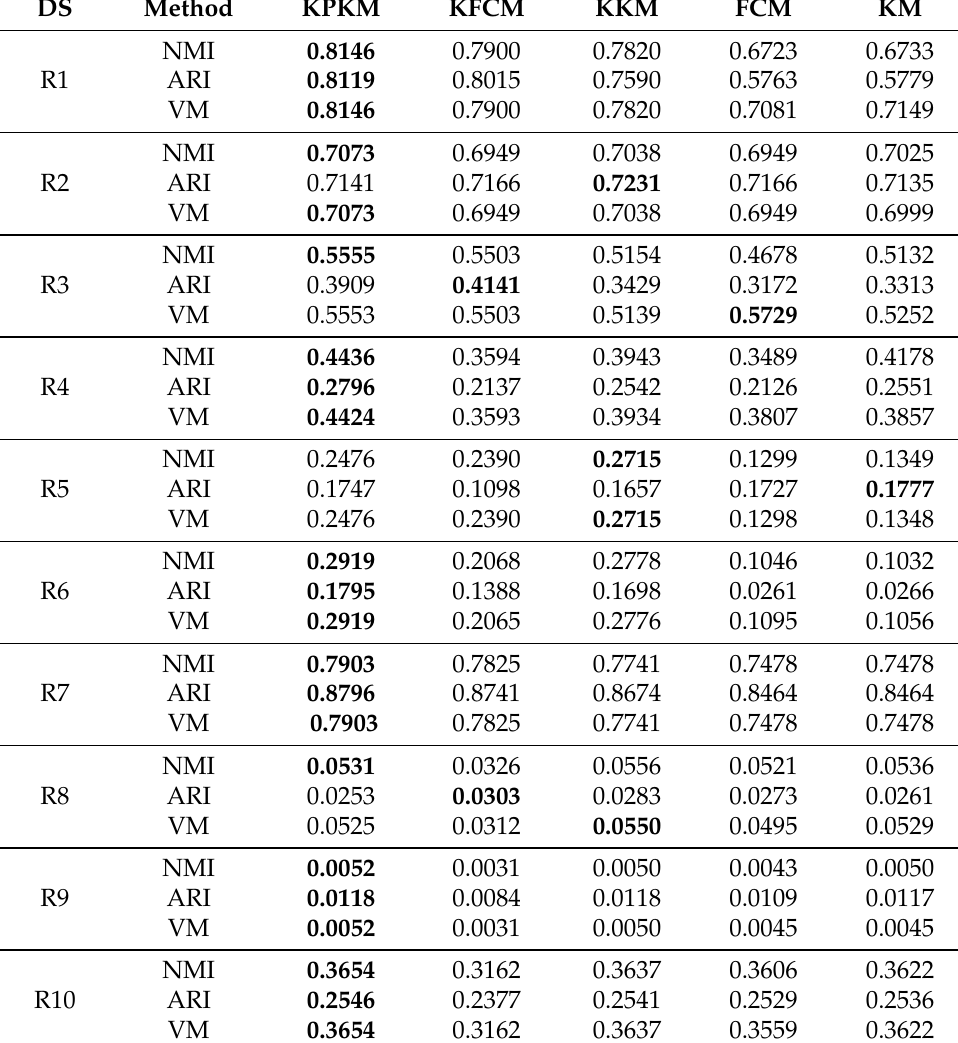
Table 4. Comparisons of KPKM with kernel fuzzy c-means (KFCM), kernel k-means (KKM), fuzzy c- means (FCM), and k-means (KM) on ten UCI datasets (DS) in terms of normalized mutual information (NMI), adjusted Rand index (ARI), and v-measure